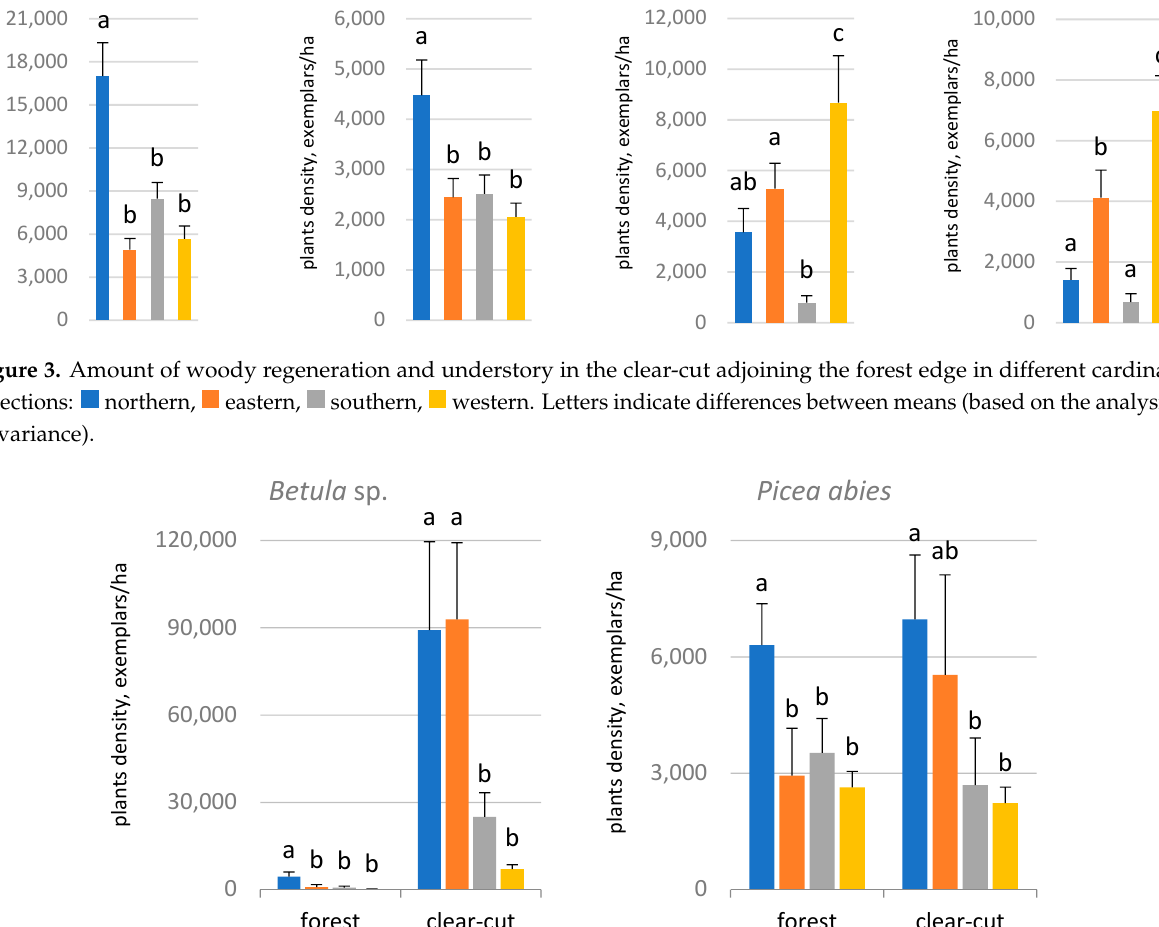
Betula sp. Betula sp. Figure 3. Amount of woody regeneration and understory in the clear-cut adjoining the forest edge in different cardinal directions: northern, eastern, southern, western. Letters indicate differences between means (based on the anal- ysis of variance).